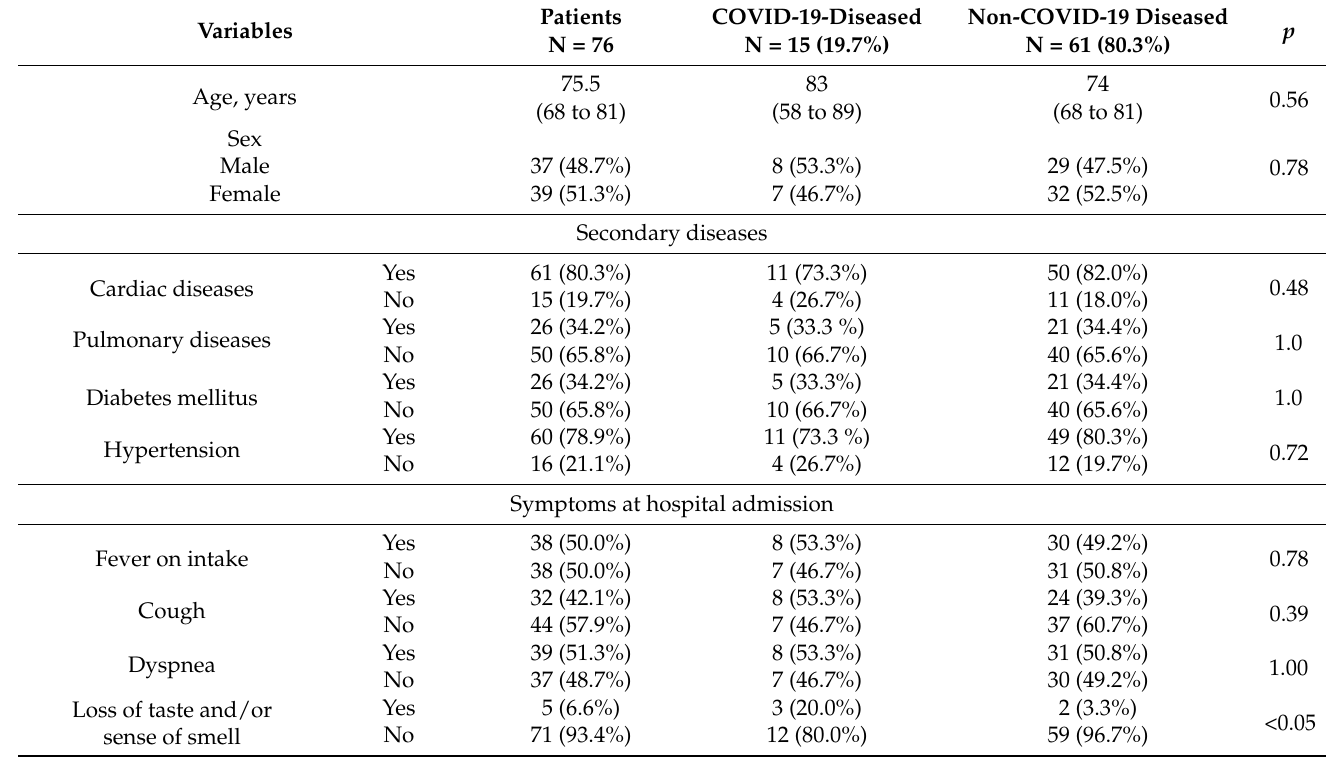
Table 1. Baseline characteristics of the study patients with secondary diseases and clinical